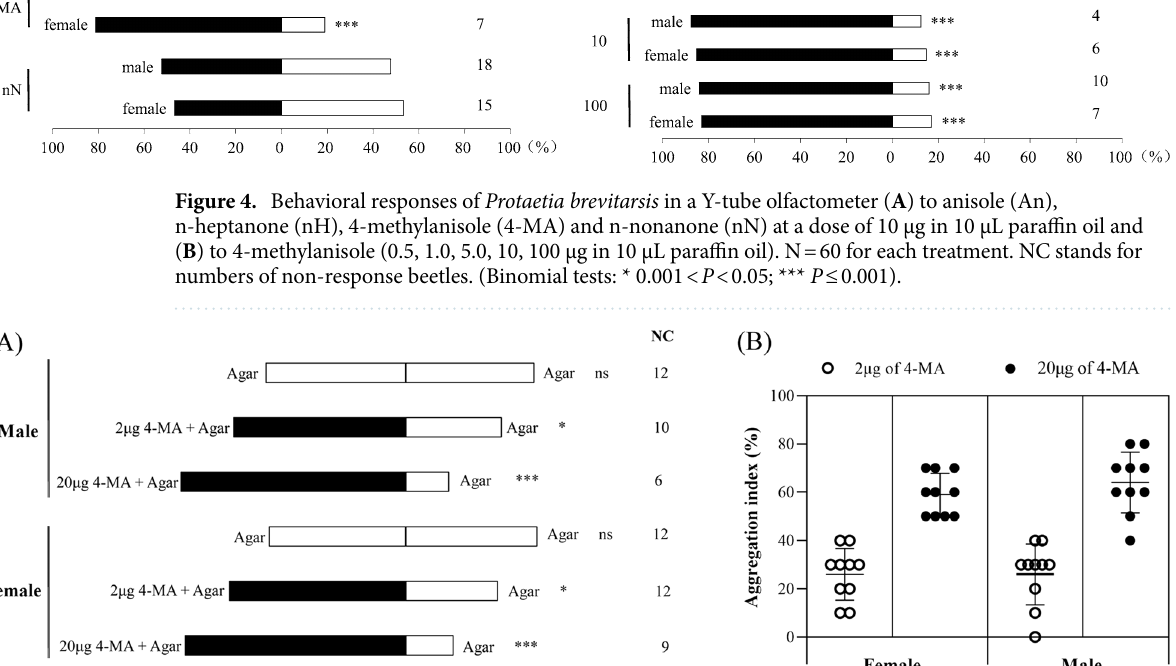
Figure 5. The behavioural preference of Protaetia brevitarsis in a dual-choice arena to agar-gel with or without 4-methylanisole (4-MA). ( A ) choice percentage of P. brevitarsis to control or treated agar-gel. NC stands for numbers of non-response beetles. (Binomial tests: ns, P > 0.05; * 0.001 < P < 0.05; *** P ≤ 0.001). ( B ) aggregation index of P. brevitarsis to 2 μg and 20 μg 4-MA treated agar-gel. The brackets represent standard